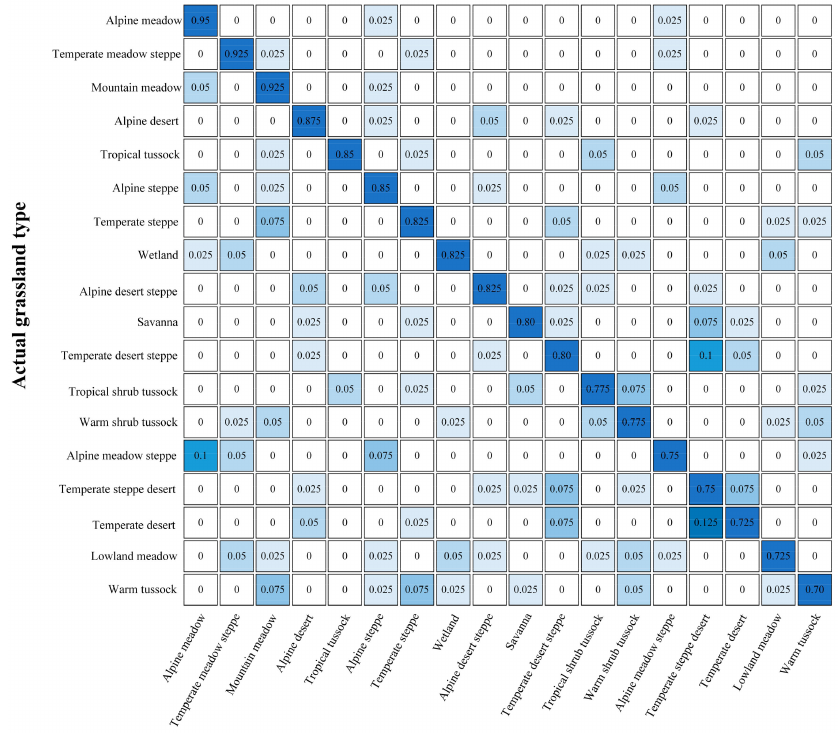
Figure 8. Confusion matrix for the recognition results for each grassland